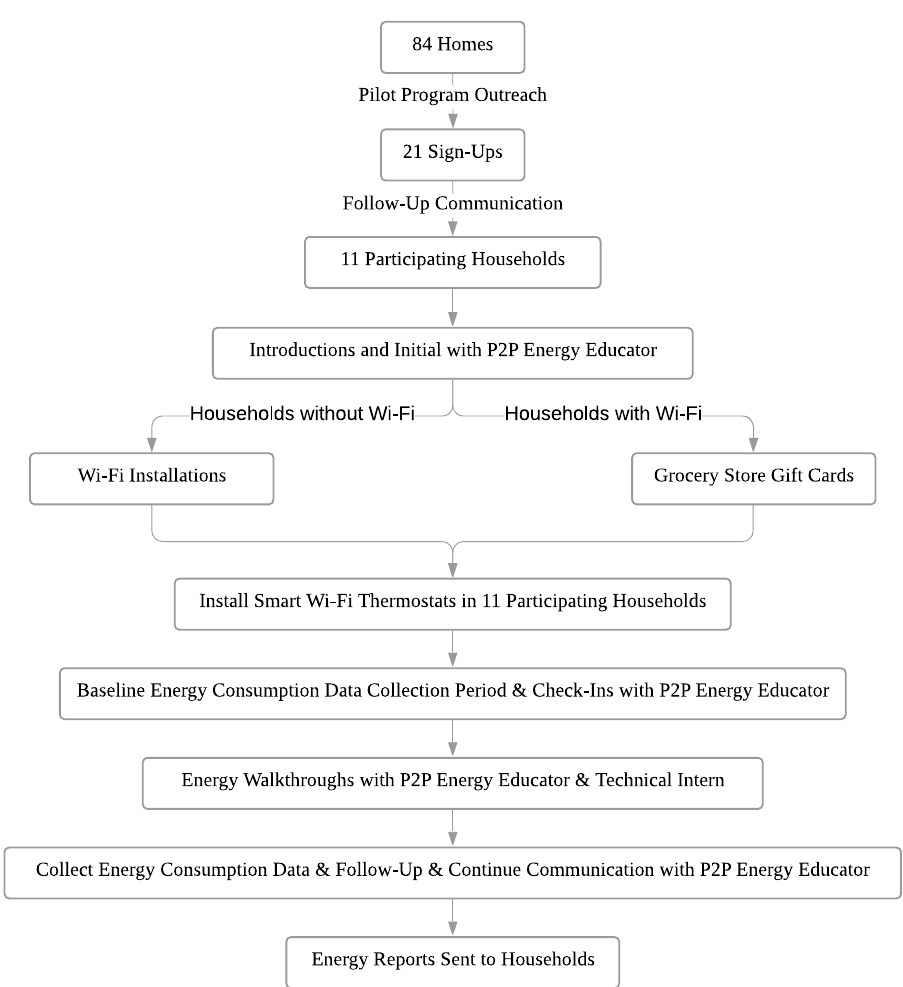
Figure 1. Pilot program process diagram: the pilot program began by conducting outreach to the 84 homes, which resulted in 21 initial sign-ups and 11 final participating households. Following initial introductions and communication with the P2P energy educator, Wi-Fi was installed in participating households that did not have Wi-Fi and grocery store gift cards were distributed to households with Wi-Fi already installed in order for smart Wi-Fi thermostats to be installed in the 11 participating households. There was then a short period in which baseline energy consumption data was collected when the P2P energy educator maintained frequent communication with participants. Energy walkthroughs were then completed with each household, and after further data collection and follow-up with the P2P energy educator, individualized energy reports were generated and sent to each participating household.